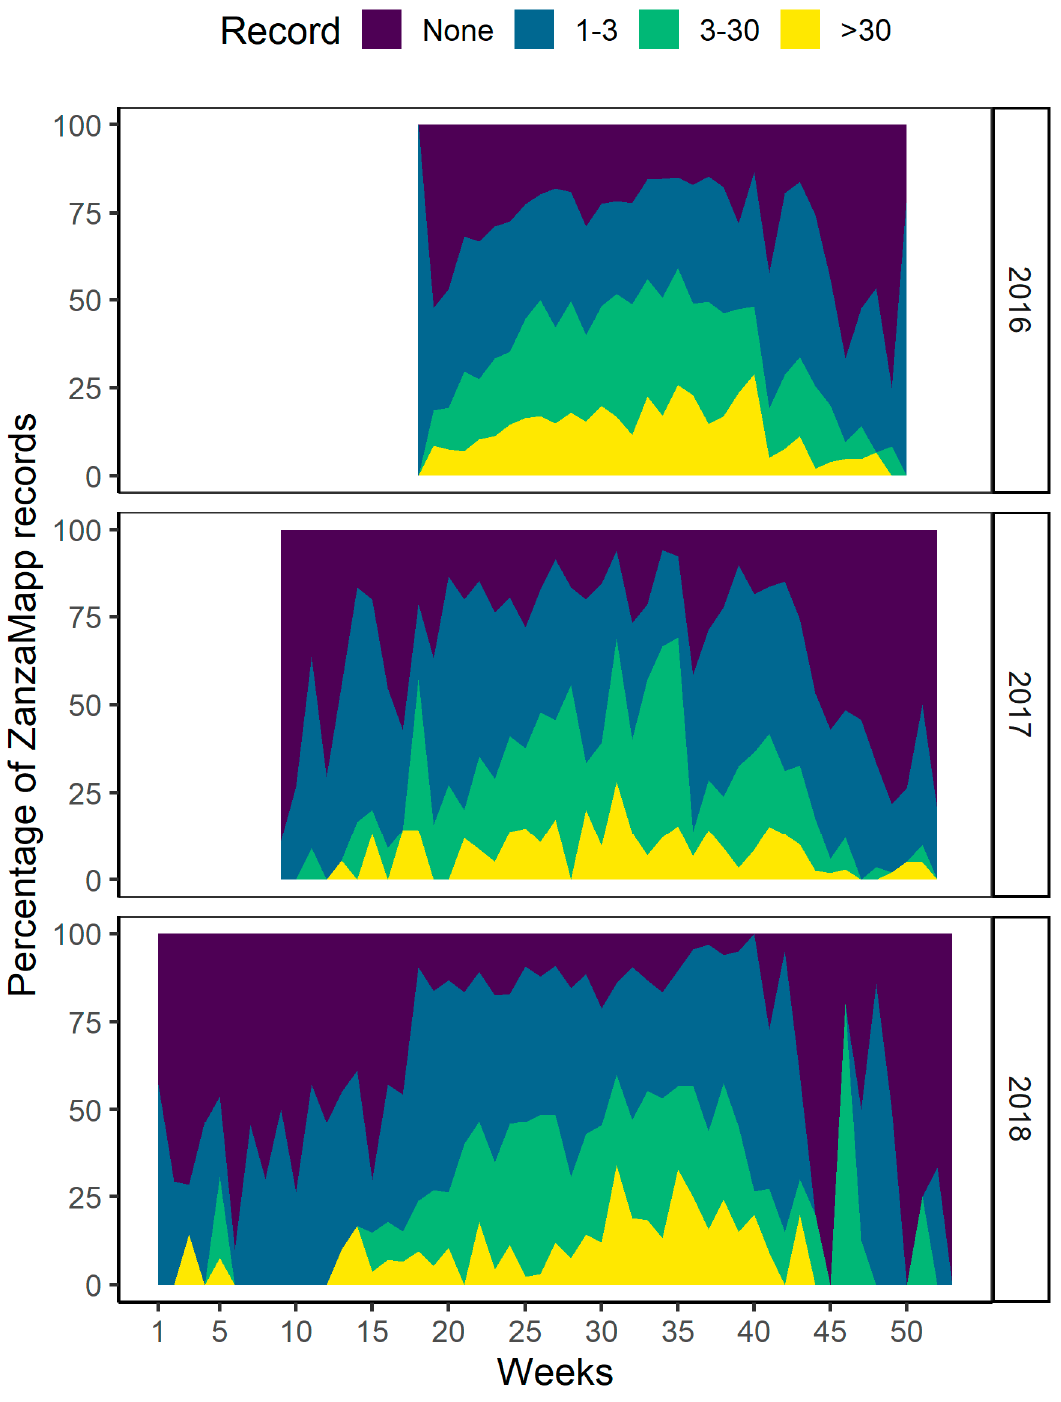
Figure 2. Seasonal distribution of proportion of ZanzaMapp mosquito abundance categories. Dark blue = zero mosquito/week (m/w); light blue = 1–3 m/w; green = 3–30 m/w; yellow = >30 m/w; Gap between week 51 of 2016 and week 8 of 2017 is due to lack of records.